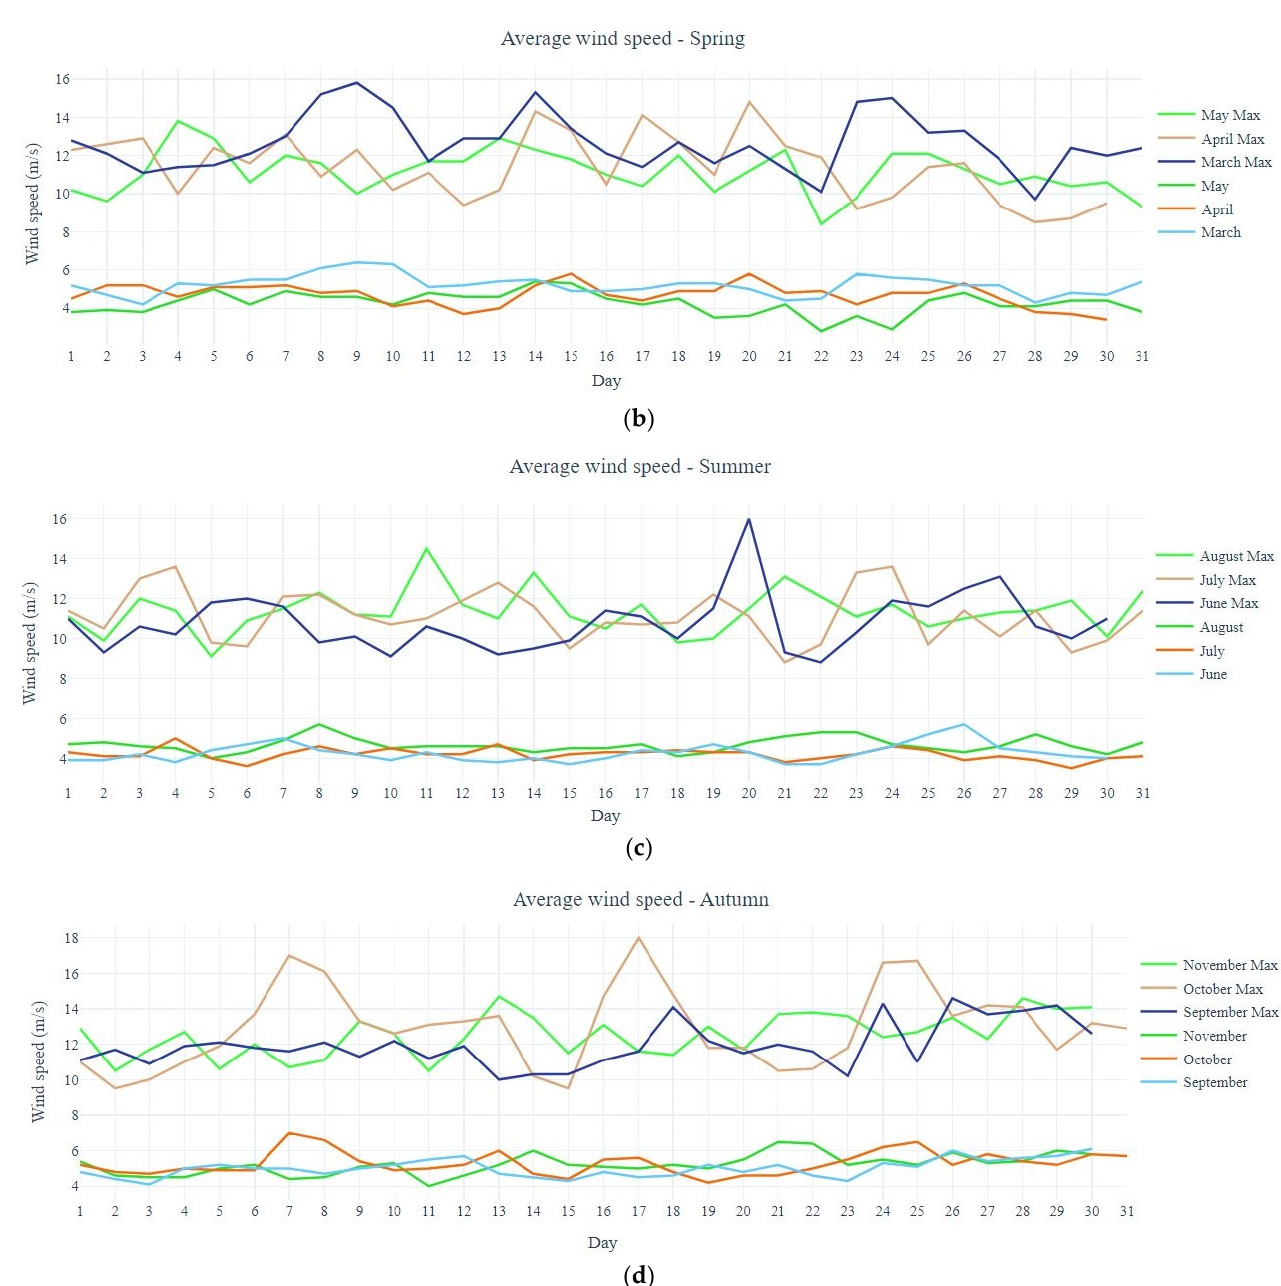
Figure 4. Monthly wind speed analysis; ( a ) winter; ( b ) spring; ( c ) summer; ( d ) autumn.